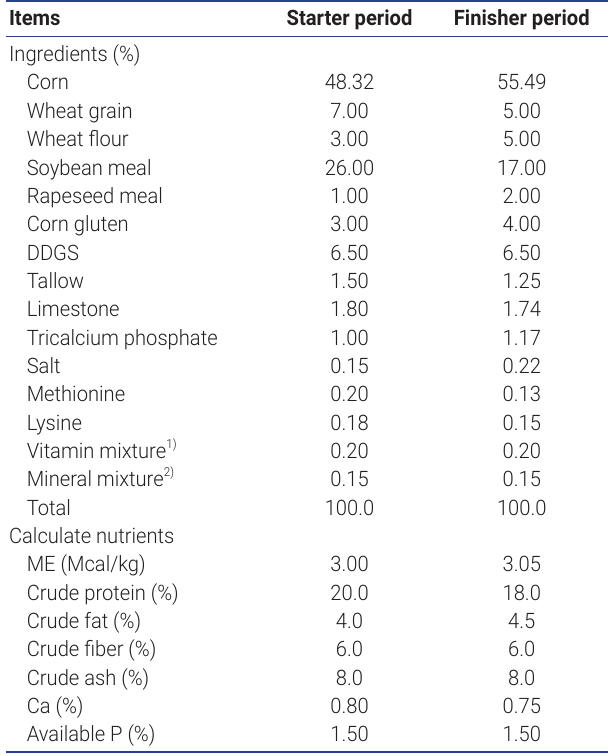
Table 1. The feed formula and chemical composition of starter and finisher period of broiler diet